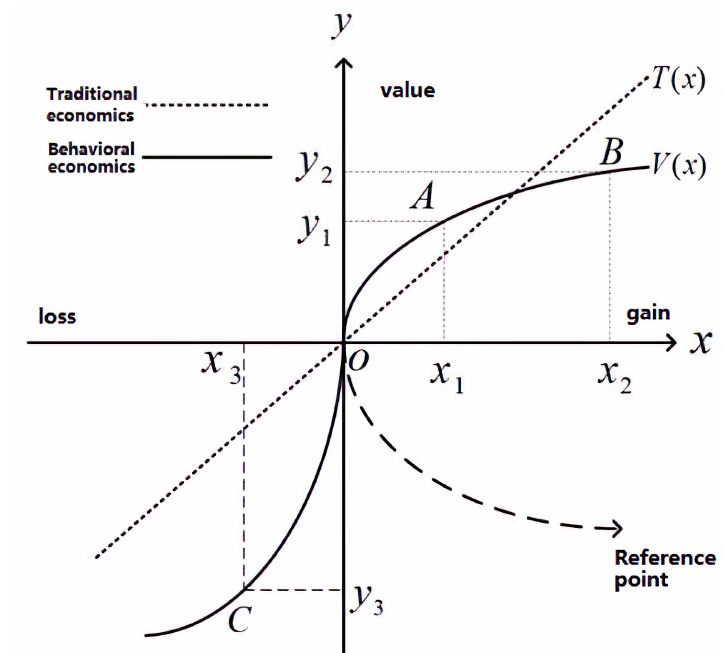
Figure 1. Value function of loss